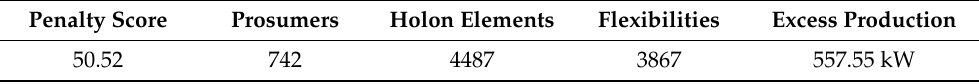
Table 1. Summary of information about the oversupply situation for the example grid.